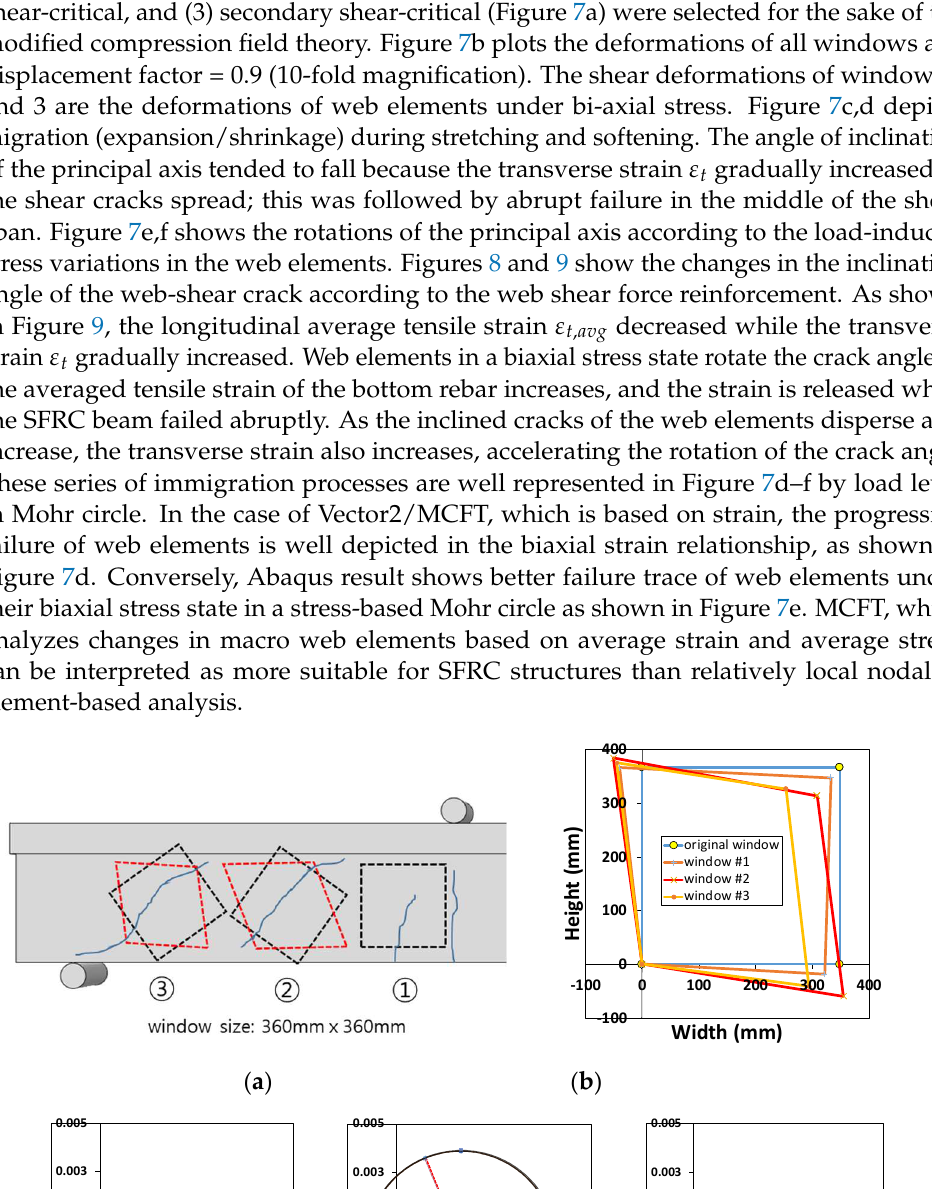
Figure 6 . Failure patterns of the SFRC T-beam under the three-point bending test. (a) Crack patterns of ABAQUS. (b) von-Mises stress in the reinforcements. (c) Tensile damage. (d) Crack patterns of Vector2.